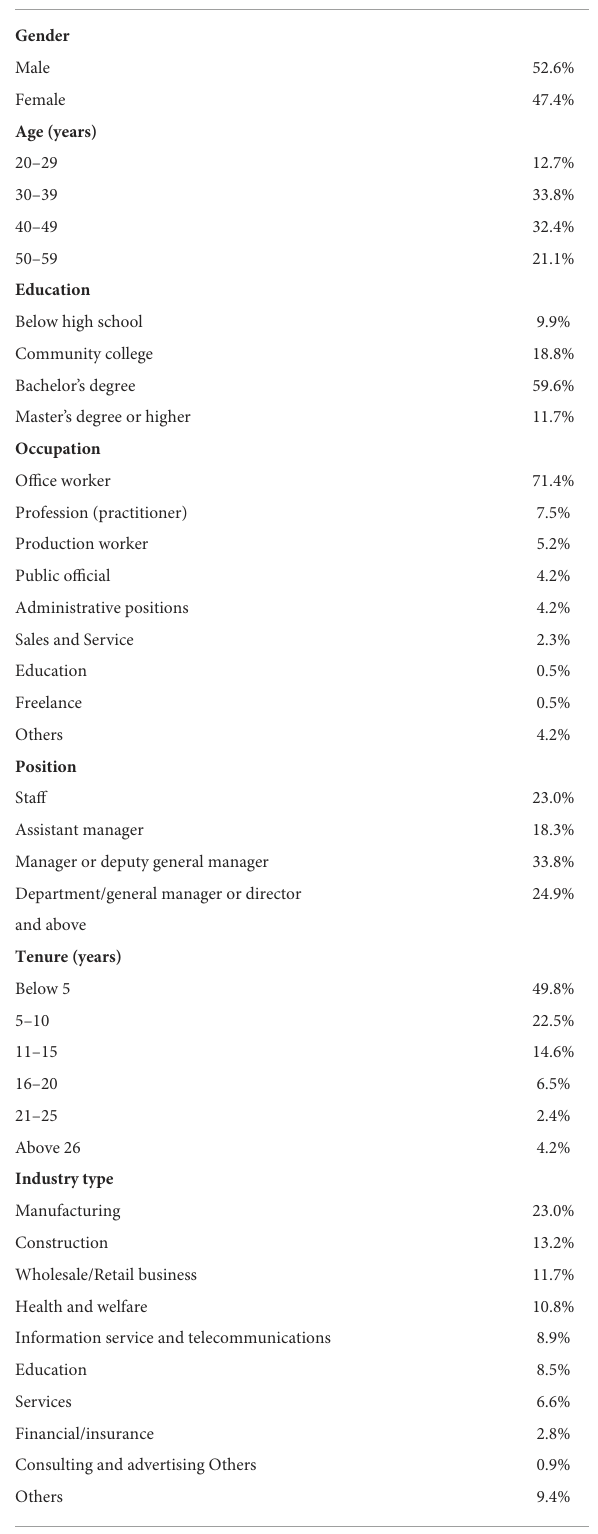
TABLE 1 Descriptive characteristics of the